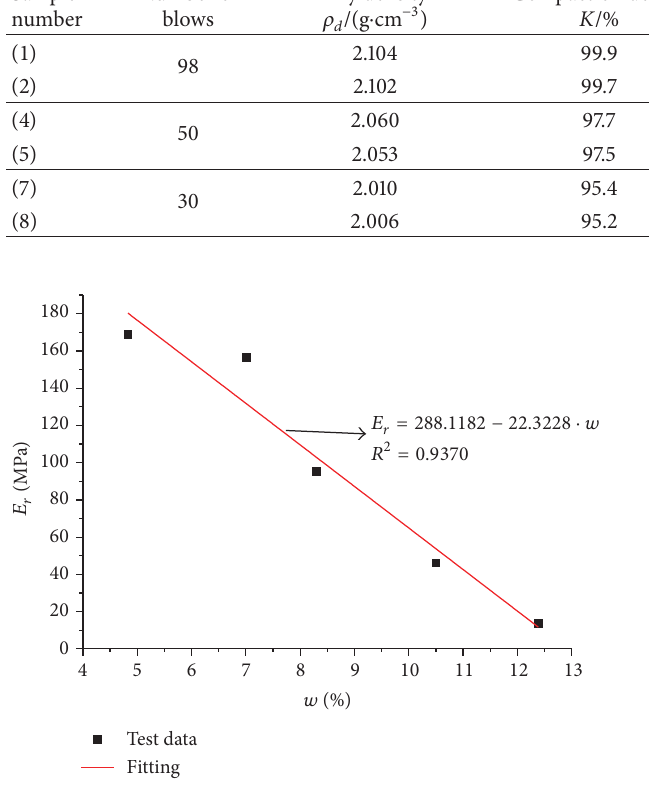
Figure 6: Relation between resilient modulus 𝐸 𝑟 and moisture content 𝜔 .